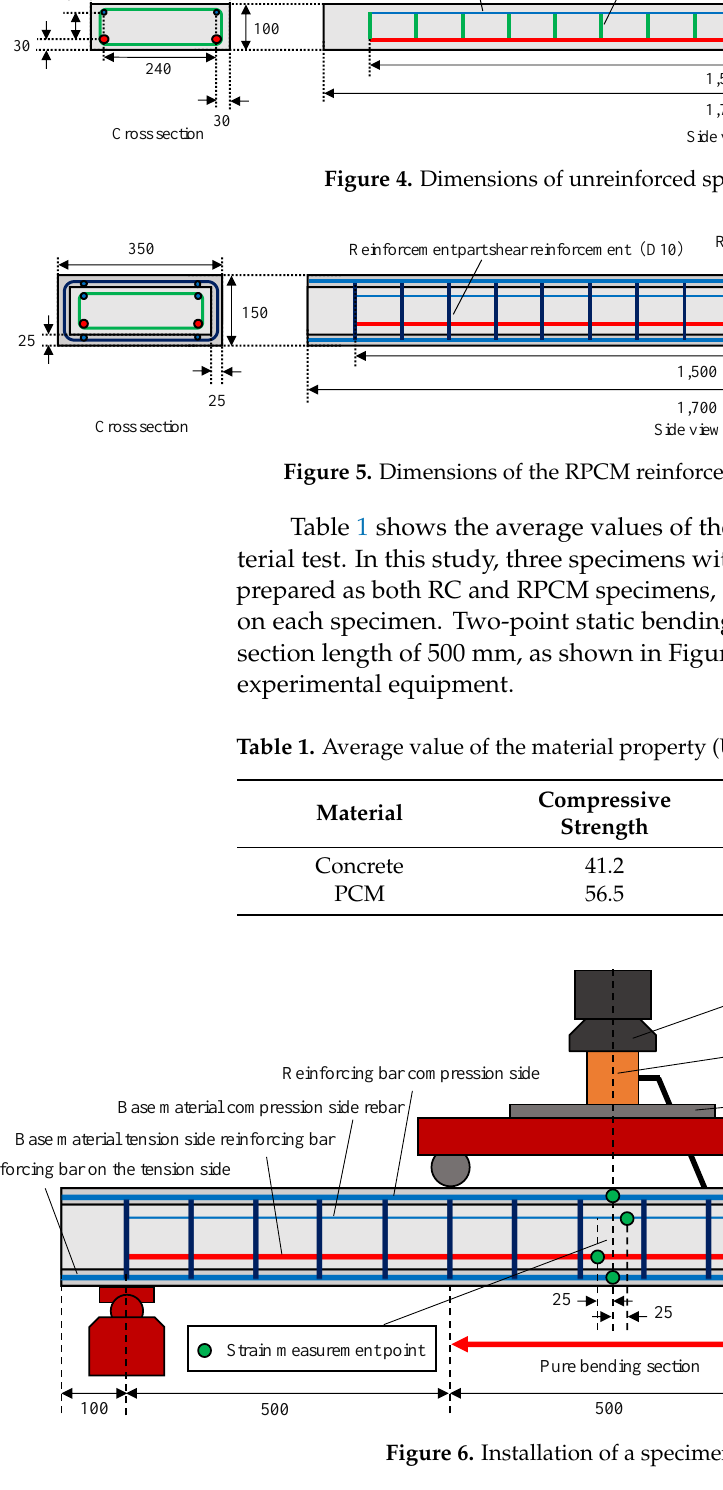
Figure 6. Installation of a specimen.